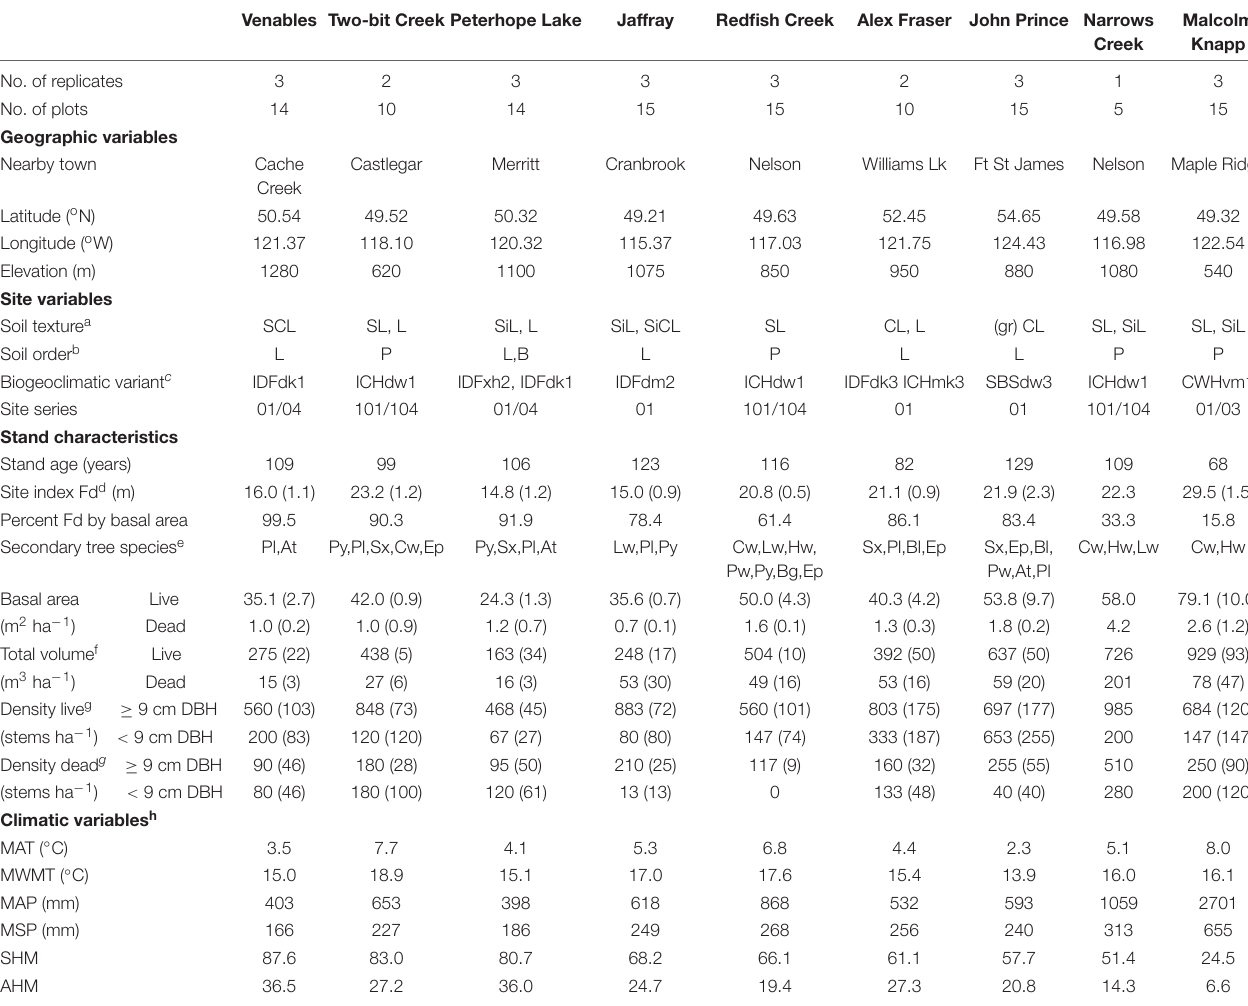
TABLE 1 | Geographic, site, stand and climatic characteristics of each research